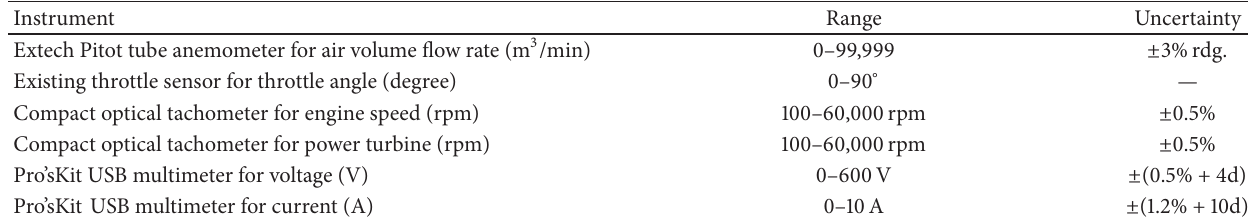
Table 2: Details of the instrumentation used in the experiment.